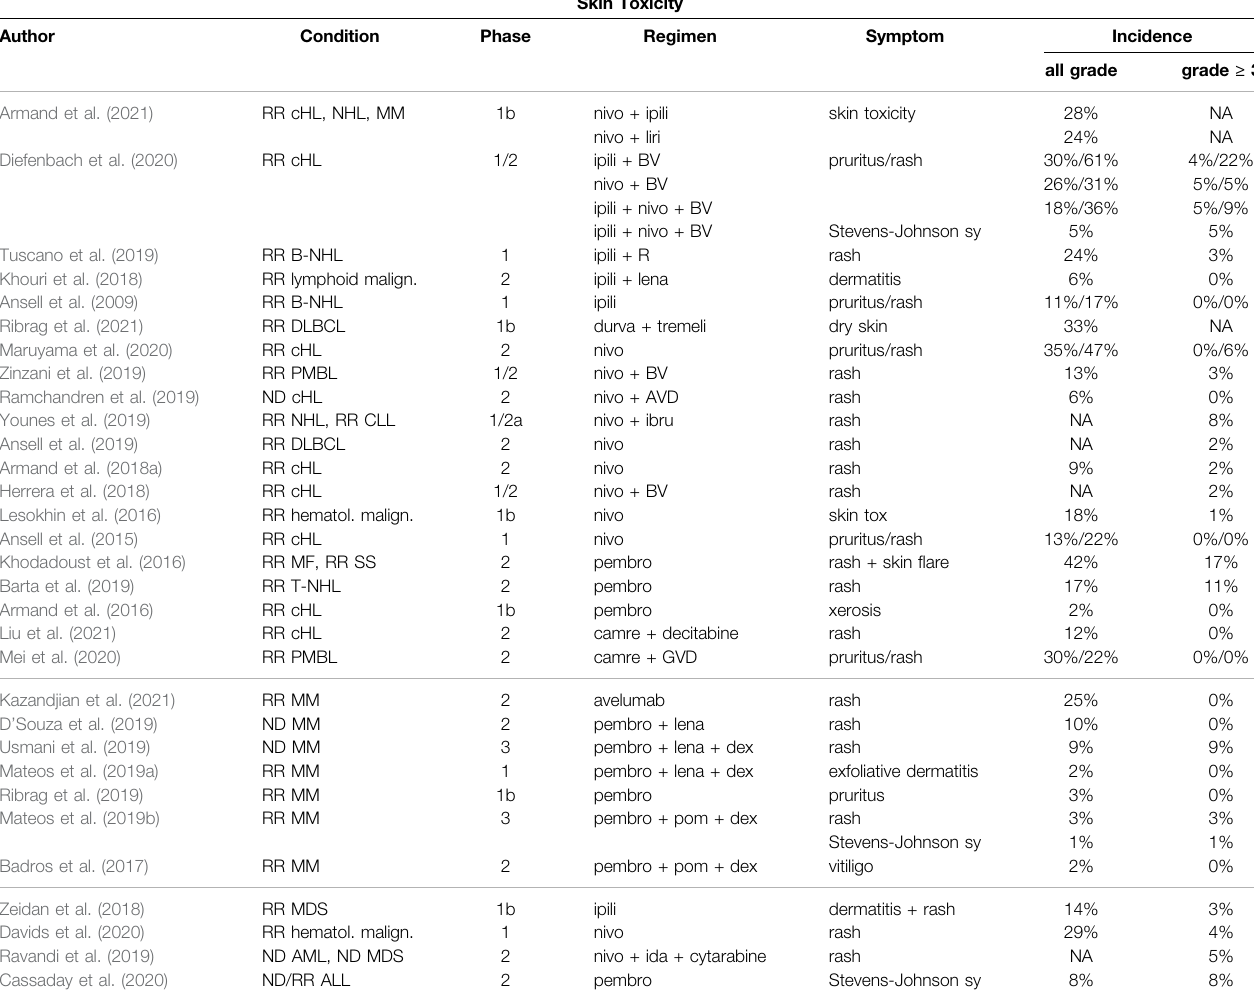
TABLE 1 | Incidence of skin irAEs in hematological